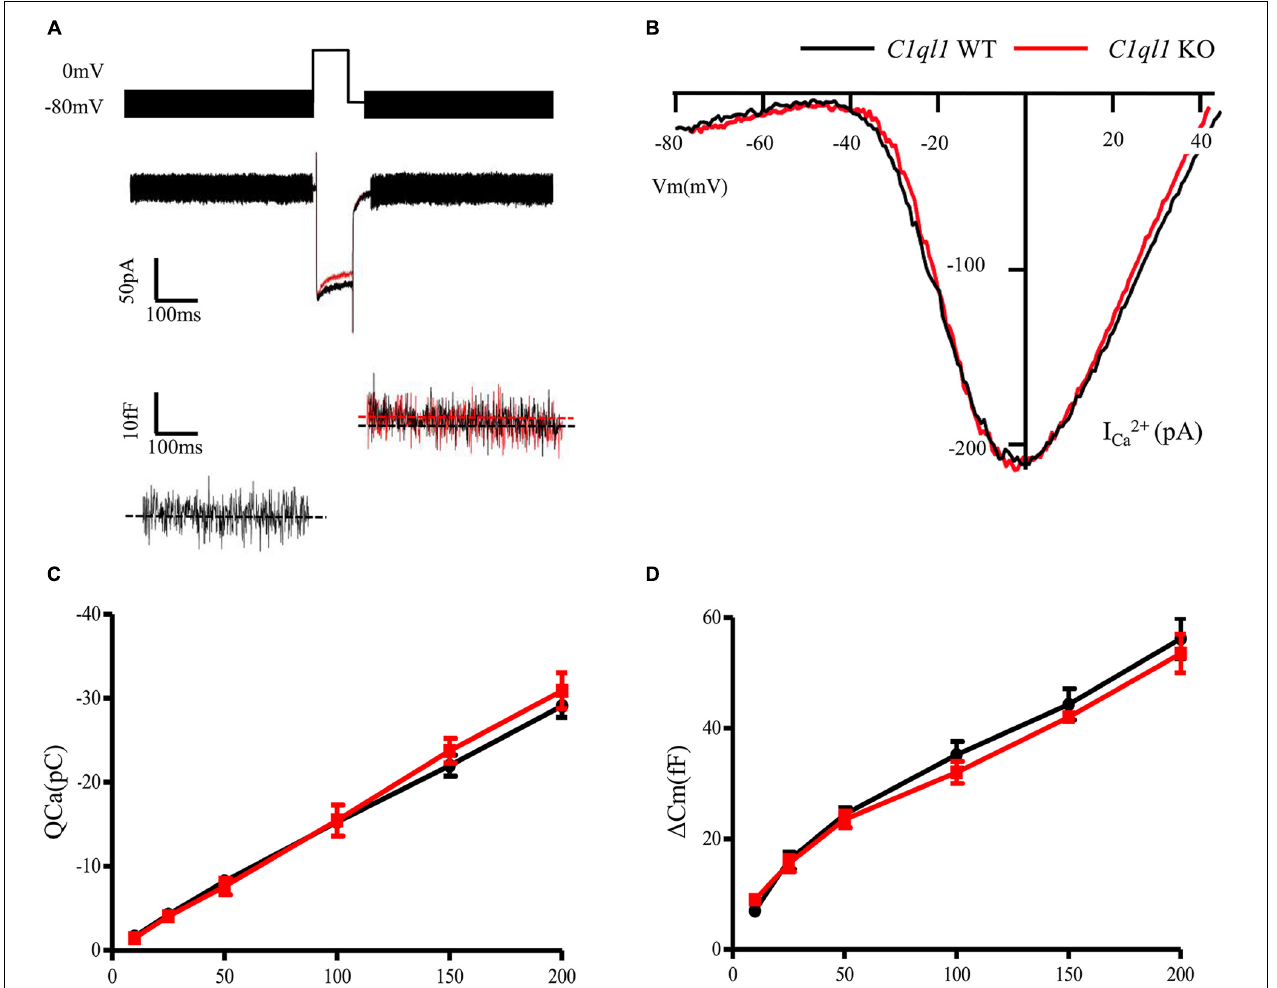
FIGURE 7 | Function of cochlear inner hair cells in C1ql1 WT mice and C1ql1 KO mice. (A) The wave of potential changes in IHCs of C1ql1 WT mice and C1ql1 KO mice. (B) The IHCs in C1ql1 KO mice also had normal biophysical properties. Ca++ current of IHCs seemed to be quite normal in C1ql1 KO mice compare to WT mice. (C) Integral Ca++ current as a function of depolarization duration (in milliseconds). (D) Change in membrane capacitance as a function of depolarization duration (in